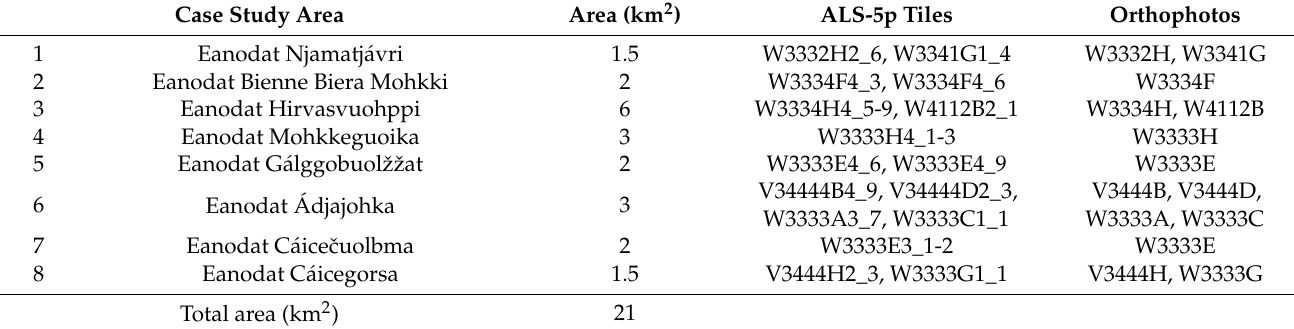
Table 1. Case study areas 1–8 and the used ALS-5p tiles [17] and orthophotos